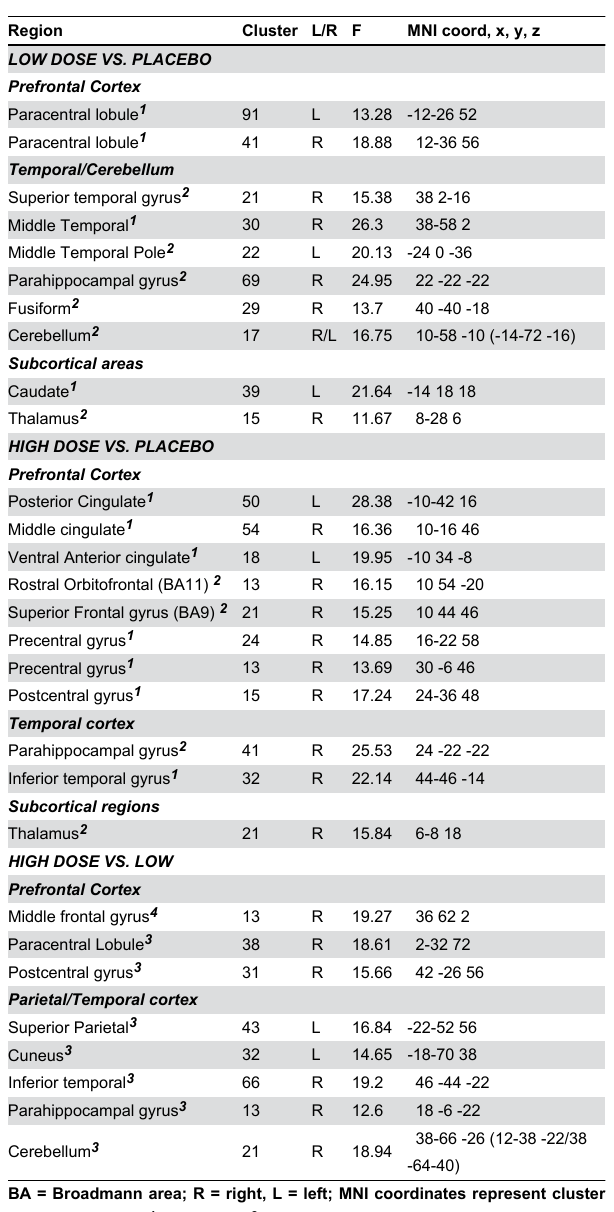
Table 10. Activations resulting from the Stop_VSST_C>Go_VSST_C contrast One-way ANOVA (p <.005, k ≥ 13